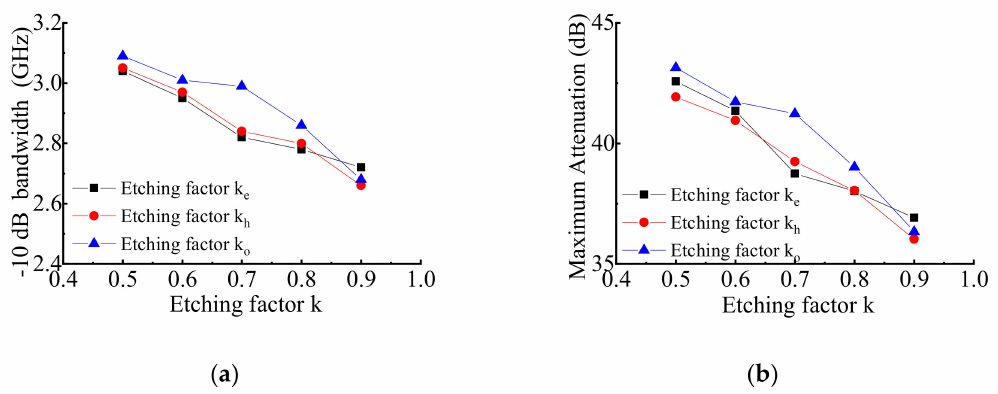
Figure 21. ( a ) Comparison of simulation of − 10 dB bandwidth with three etching factors; ( b ) comparison of the simulations of the maximum attenuation of stopband with three etching